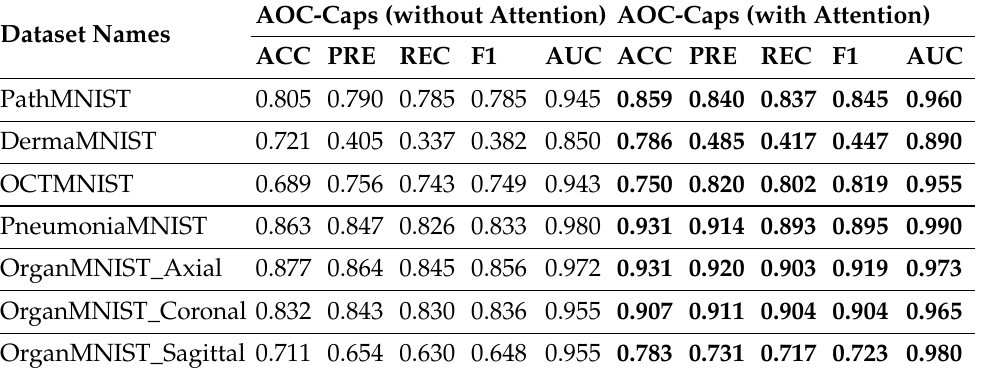
Table 11. Performance of AOC-Caps with/without attention